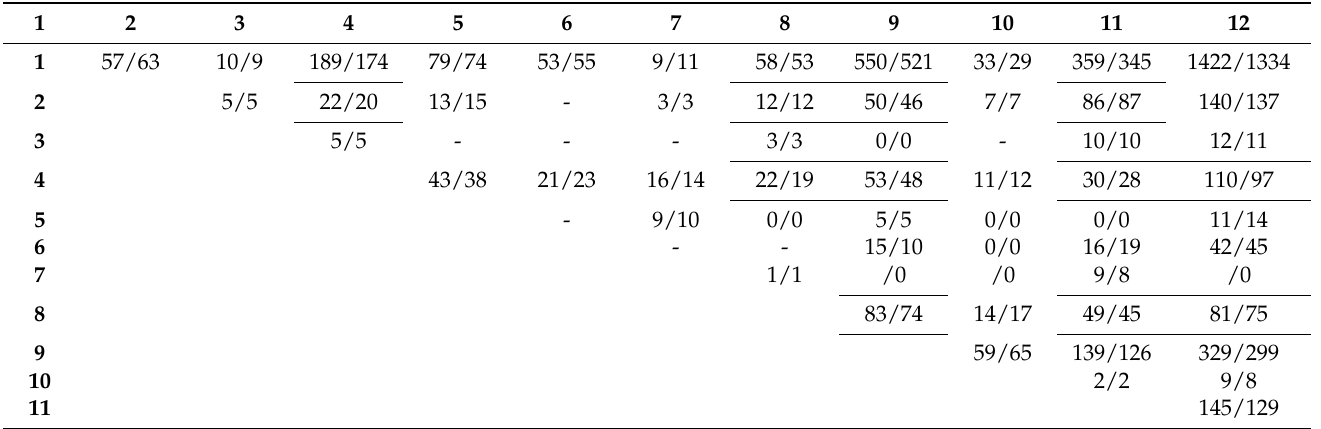
Table 7. Passenger flow of each OD pair (before/after optimization).